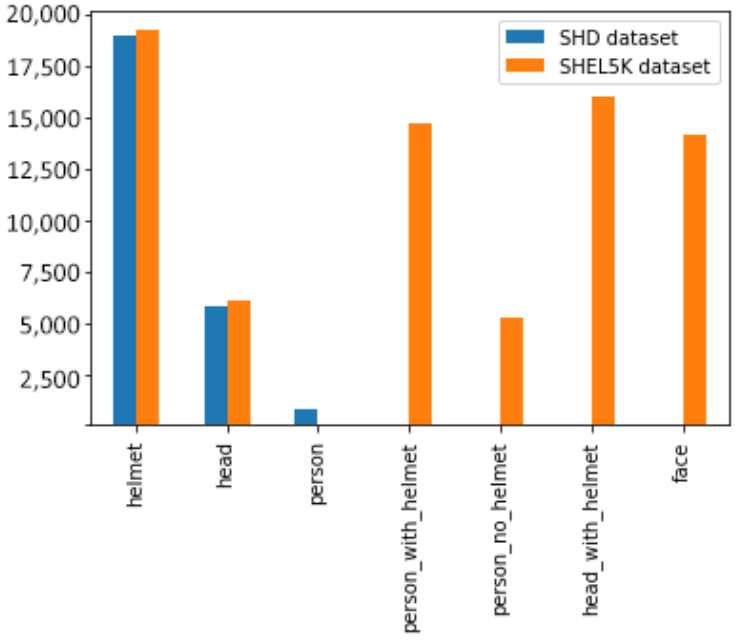
Figure 4. Bar graph comparison between the SHD dataset [8] and SHEL5K dataset in terms of the number of labels for each